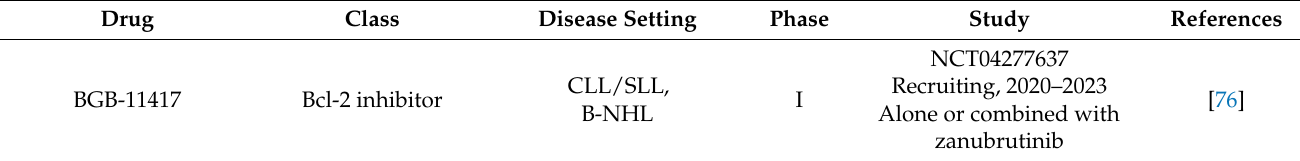
Table 3. Selected active or recruiting clinical trials of novel inhibitors of BCL2/BTK/PI3K proteins or TAAs (CD19/CD20/CD22/CD38), evaluated alone or in combination as first- or second-line therapies for B cell